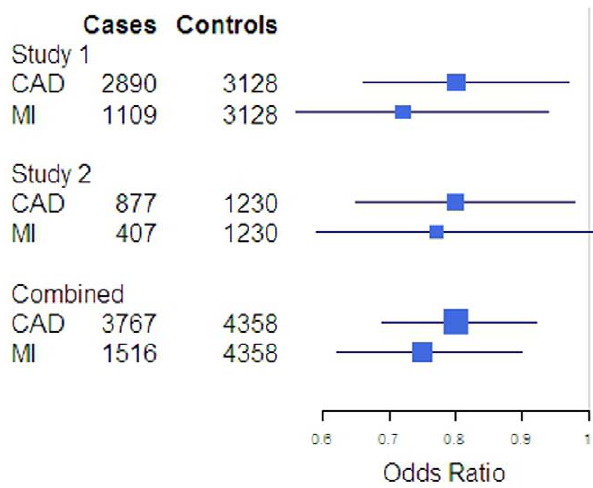
Figure 1. CAD and MI risk (OR and 95% CI) in carriers of the PLA2G7 279F compared to subjects homozygous for the common V279 allele are shown by study and combined using meta-analysis. An additive model was used therefore homozygous carriers of the 279F would be expected to have twice as much risk reduction as compared to heterozygous carriers. CAD – coronary artery disease and MI – myocardial infarction.